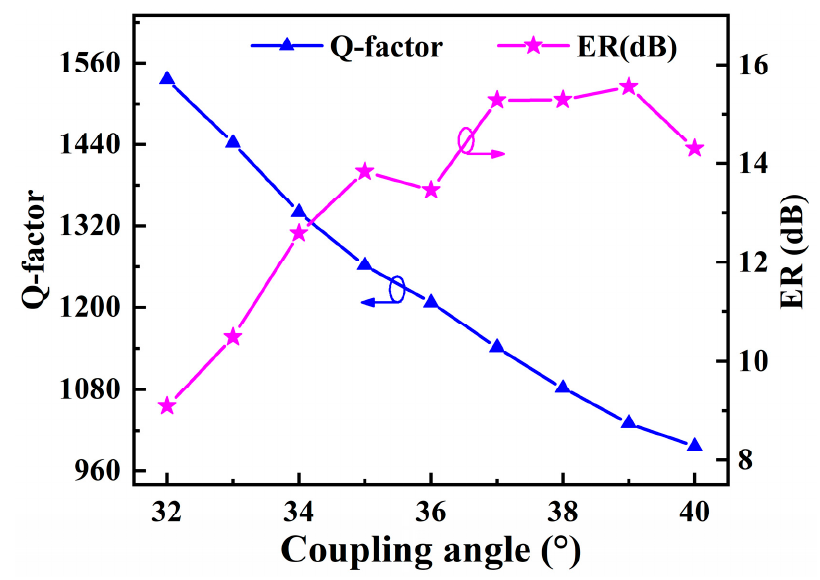
Figure 6. Dependence of Q -factor and ER of SMRR on coupling angle at the resonance wavelength. Table 1. Geometrical parameters of